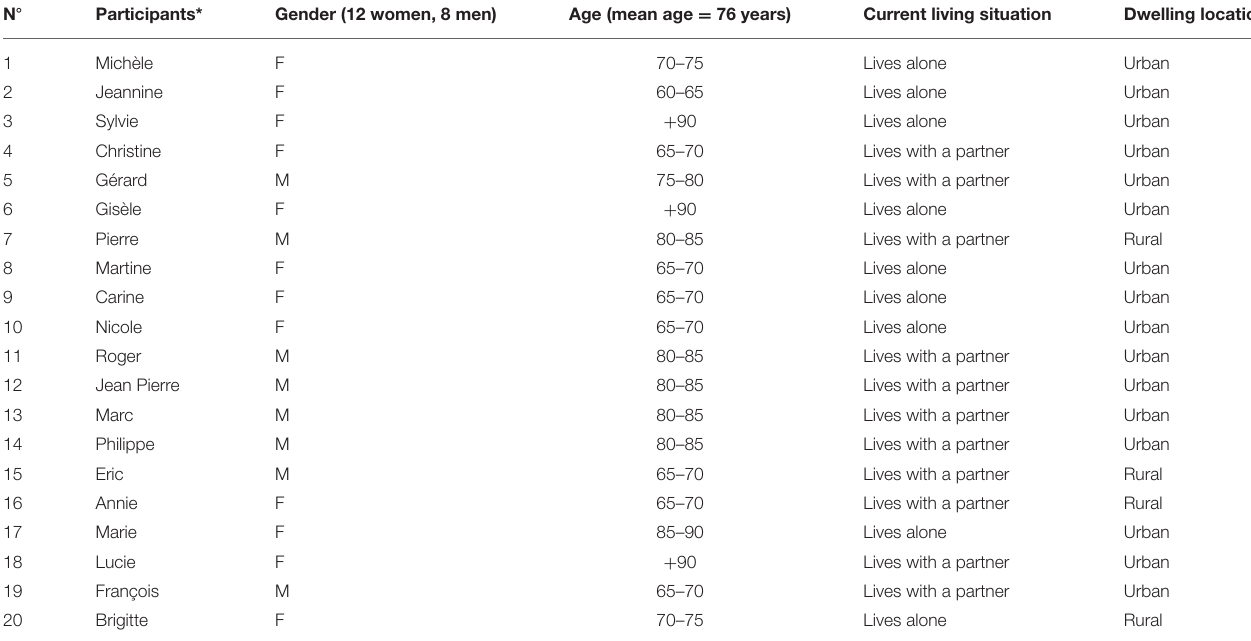
TABLE 1 | Characteristics of